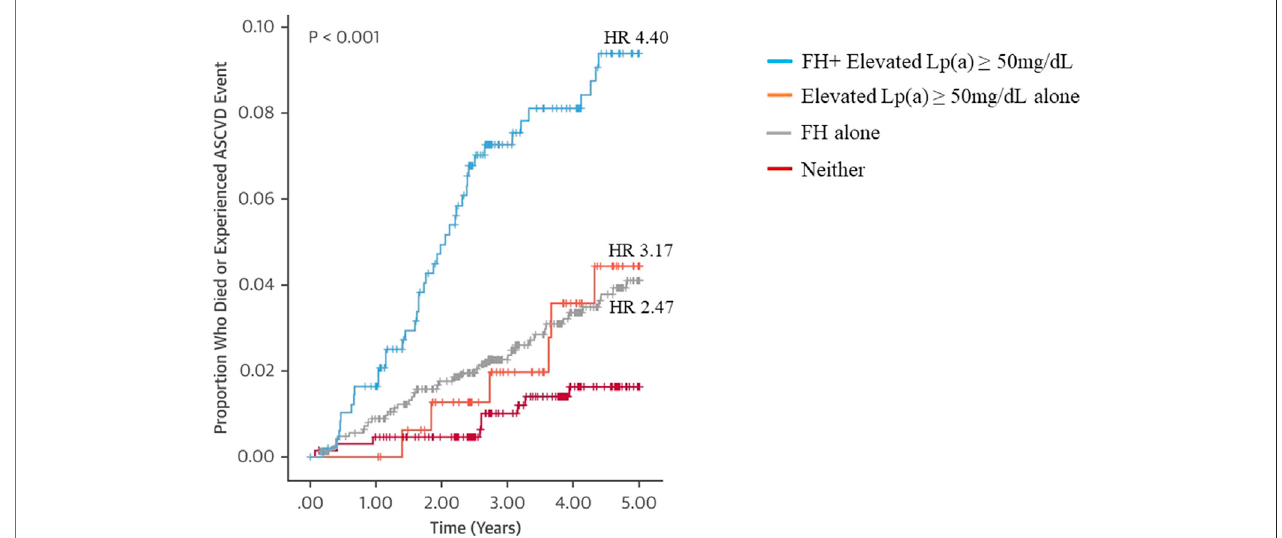
FIGURE1| Kaplan-Meier survivalanalysisshowingasigni fi cantassociationbetweentheFHandLp(a)diagnosesofrelativesand ASCVDevents.Coxproportional hazard ratio (HR) of patients with dual FH and Lp(a) diagnoses, elevated Lp(a) alone, FH alone compared with individuals with neither disorder are shown in the fi gure. Modi fi ed from Ellis KL et al. Value of Measuring Lipoprotein (a) During Cascade Testing for Familial Hypercholesterolemia. J Am Coll Cardiol. 2019; 73:1029 – 1039, with permission.